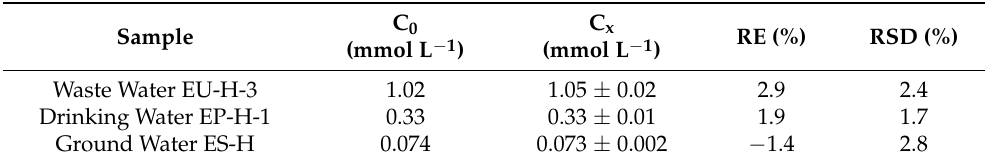
Table 3. Results of potassium determination in certified reference materials using the calibration curve method (C o and C x —certified for CRM and found concentrations respectively; RE—relative error; RSD—relative standard deviation) ( n = 6, α = 0.05).